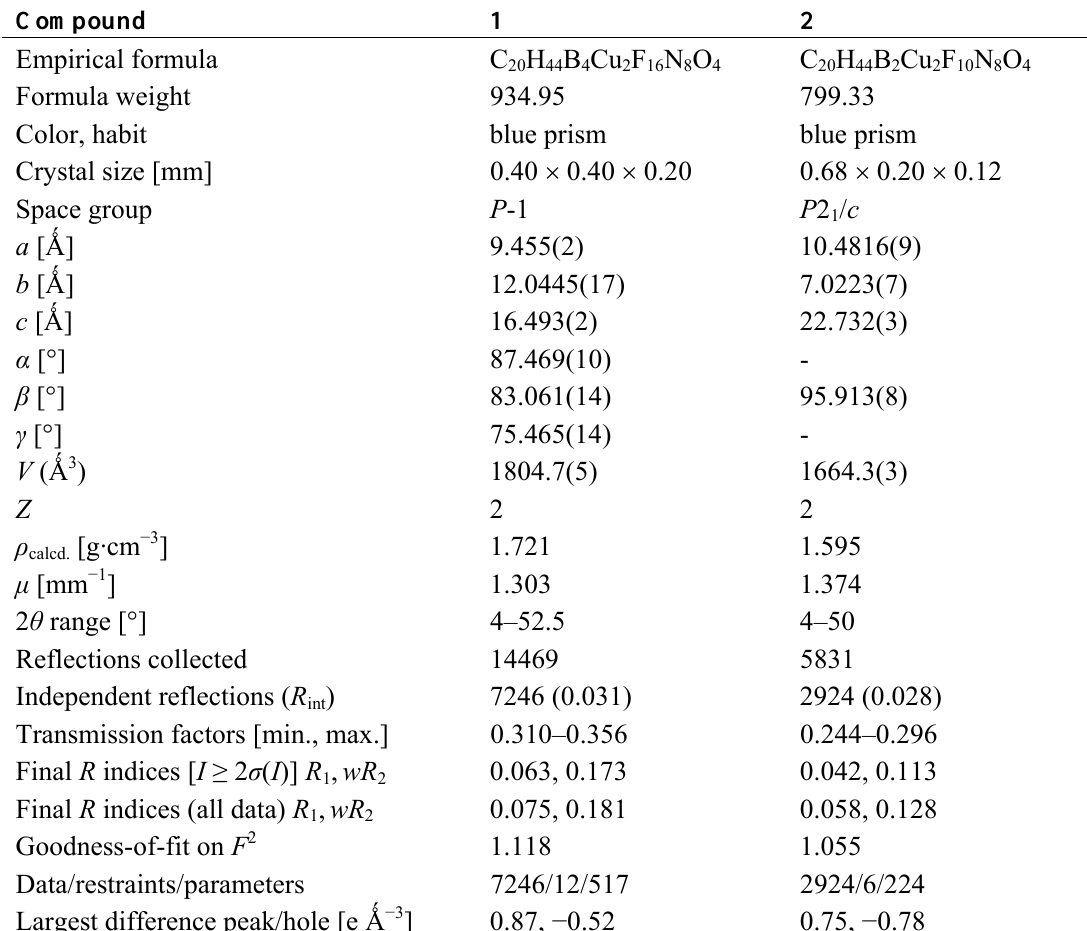
Table 2. Crystal data for complexes 1 and 2